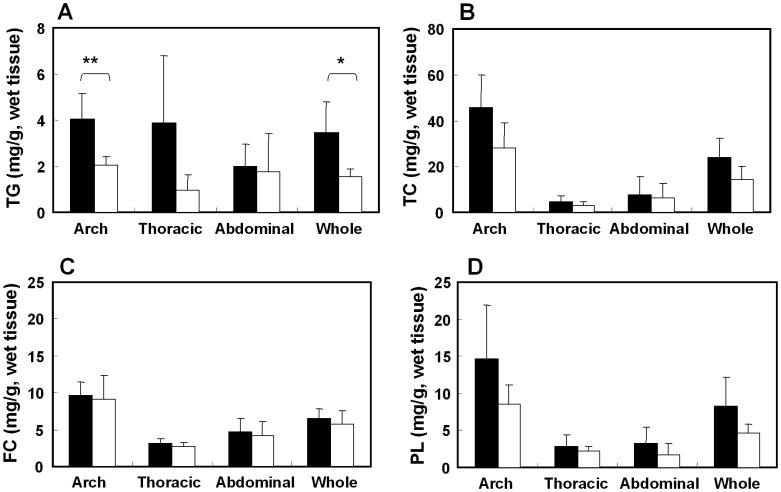
Effects of cilostazol on the lipid contents in the atherosclerotic aorta.Amounts of triglyceride (A), total cholesterol (B), free cholesterol (C) and phospholipid (D) in different regions of the aorta. Individual values of the control group are shown by closed columns and those of the cilostazol group by opened columns. Data represent means ± S.D. Control [n = 5], cilostazol [n = 5]. *: p<0.05, **: p<0.01 versus control by t-test.